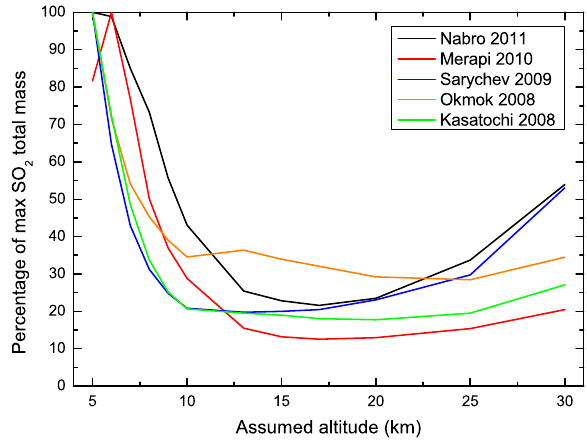
Fig. 6. Illustration of the measurement error. Relative errors in the retrieved abundances, made from introducing 0.15K and 0.25K error in the data of Fig. 3.